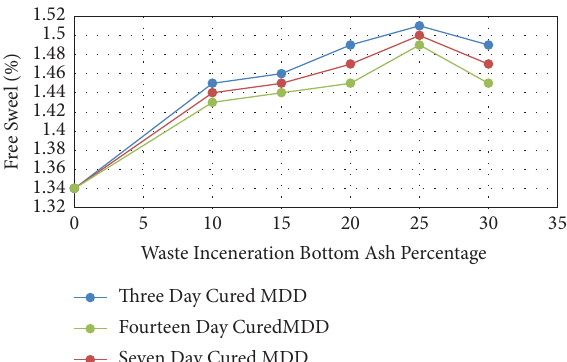
Figure 5: Efect of waste incineration bottom ash content and curing period on maximum dry density of subgrade